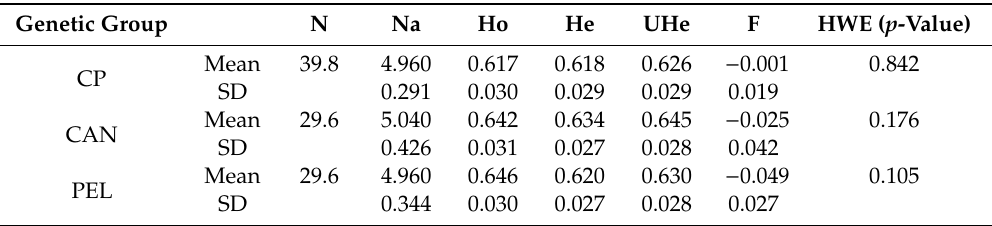
Table 2. Mean and standard deviation (SD) for di ff erent estimates obtained at each locus for the three Brazilian breeds studied.